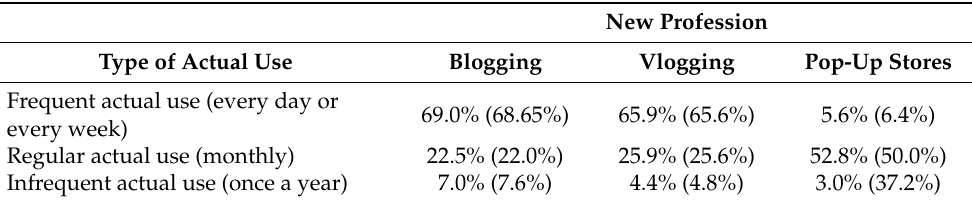
Table 3. Actual use of new professional services by new profession type. Numbers in brackets refer to the 18–34 years of age customer group.